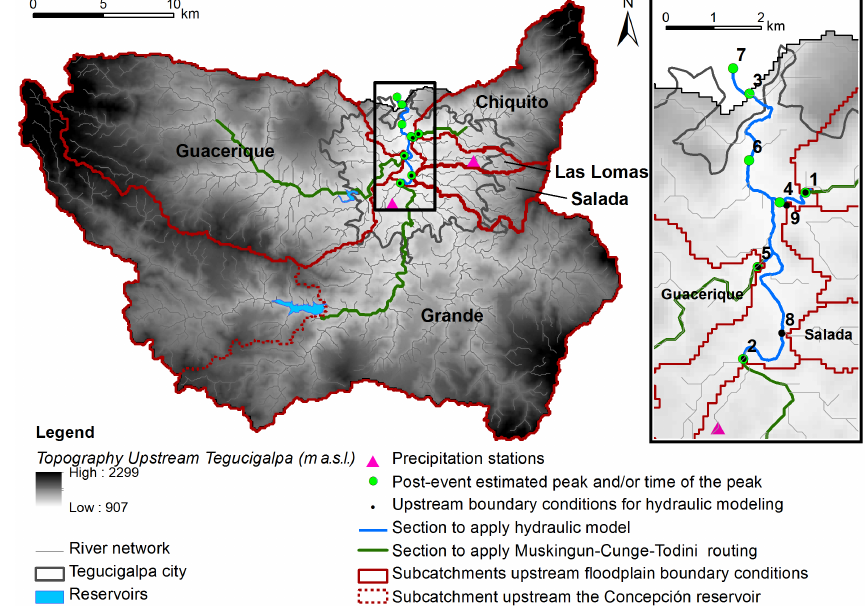
Figure 1. Study area and data location; topography data from the Shuttle Radar Topography Mission